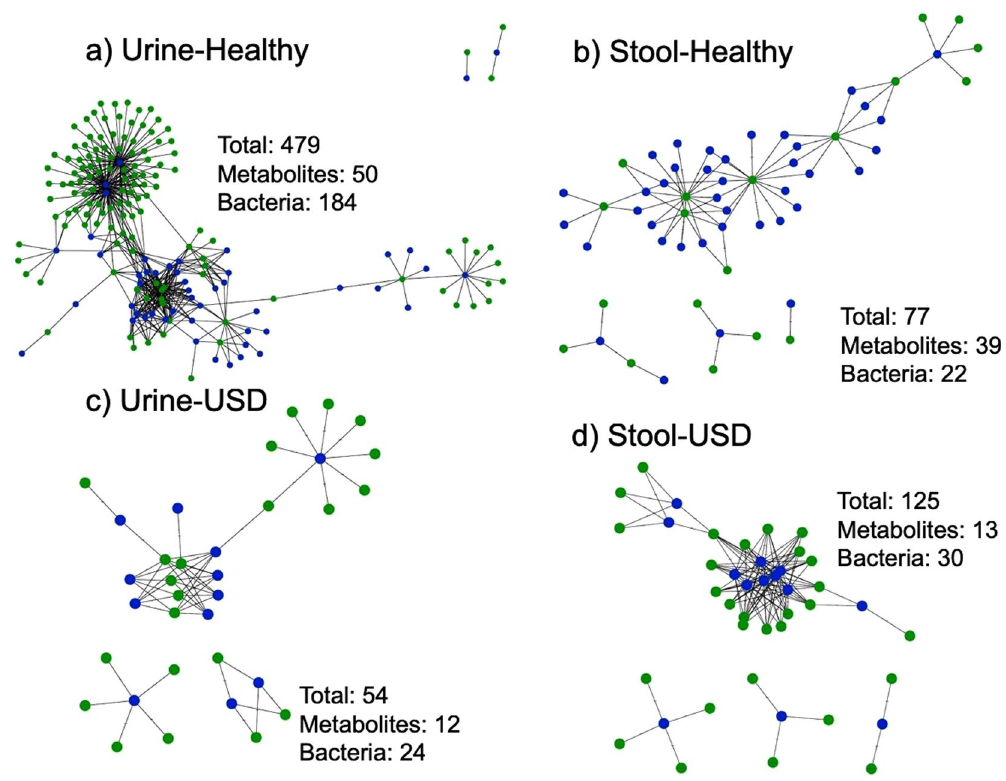
Figure 6. Microbe-Metabolite interaction networks of microbes and metabolites significantly enriched in the healthy or USD groups, for the urine metabolome & both the urine and stool microbiome. Blue = metabolites, green = microbes. Listed are the total number of interactions, number of metabolites involved, and number of bacteria involved. ( a ) Healthy, urine metabolome × urine microbiome; ( b ) Healthy, urine metabolome × stool microbiome; ( c ) USD, urine metabolome × urine microbiome; ( d ) USD, urine metabolome × stool